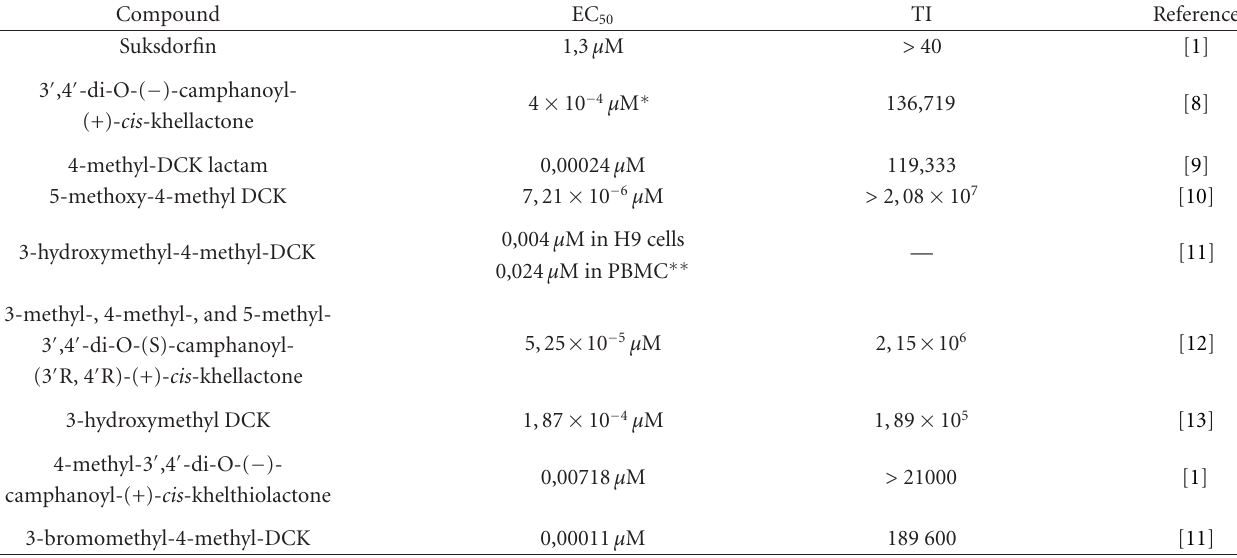
Table 1: A review of EC 50 values and TIs (defined as LD 50 /IC 50 ) for some coumarins. Compound EC